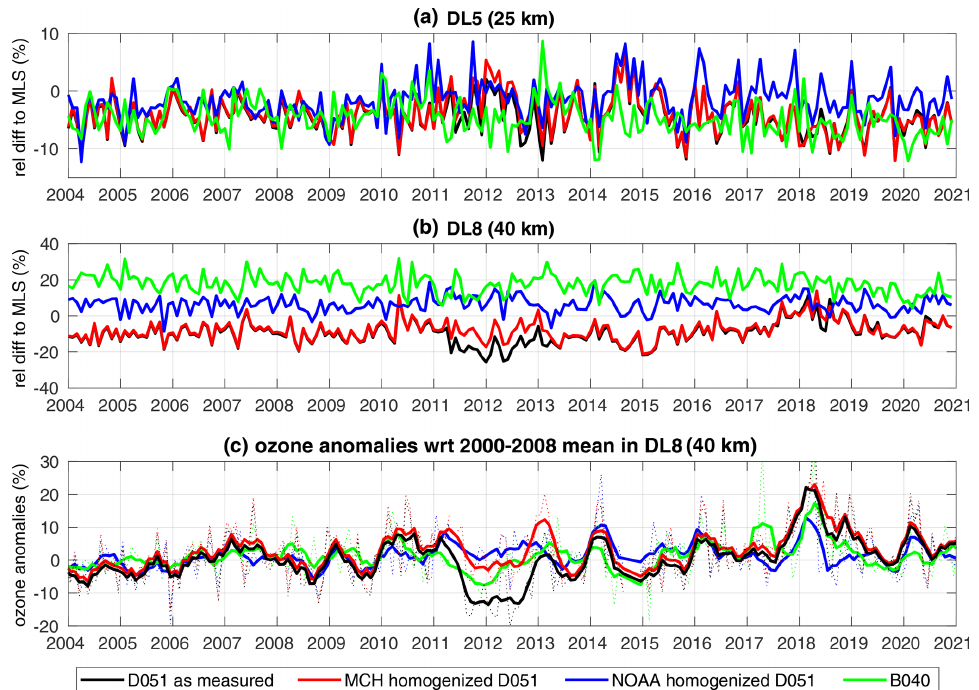
Figure 5. Monthly mean ozone content relative difference to Aura MLS of Dobson D051 as measured (black), Dobson D051 NOAA homogenized (blue), Dobson D051 MCH homogenized (this study, red) and Brewer B040 (green) deseasonalized time series in (a) DL5 and (b) DL8. (c) Time series of ozone anomalies towards their 2000–2008 mean for the same ground-based datasets in